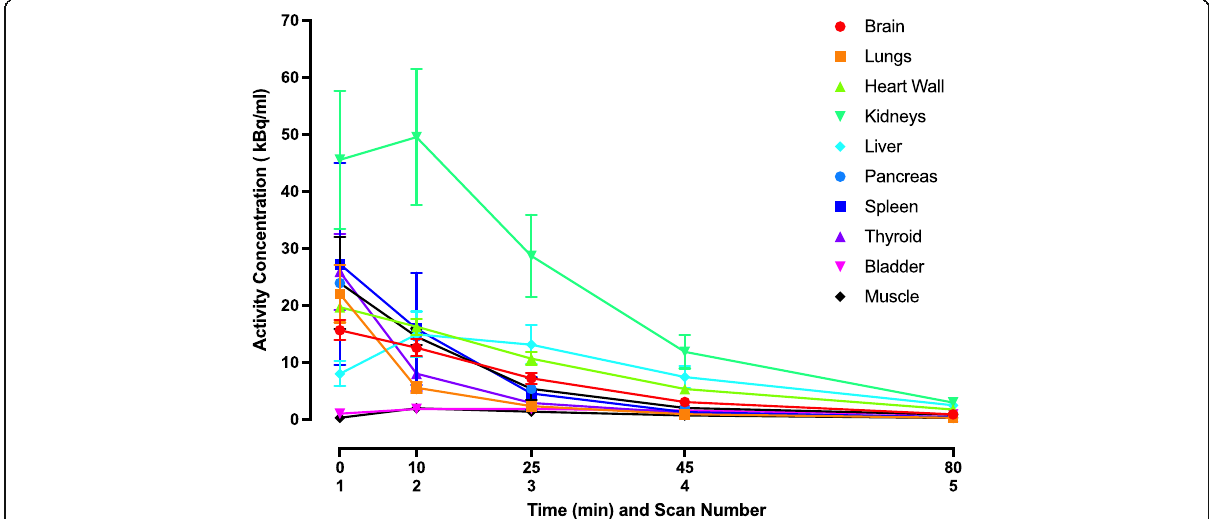
Fig. 1 Mean time-activity curves in select organs (subjects 1 – 4). Bars indicate standard deviation. Time refers to approximate start time of scan after injection of 11